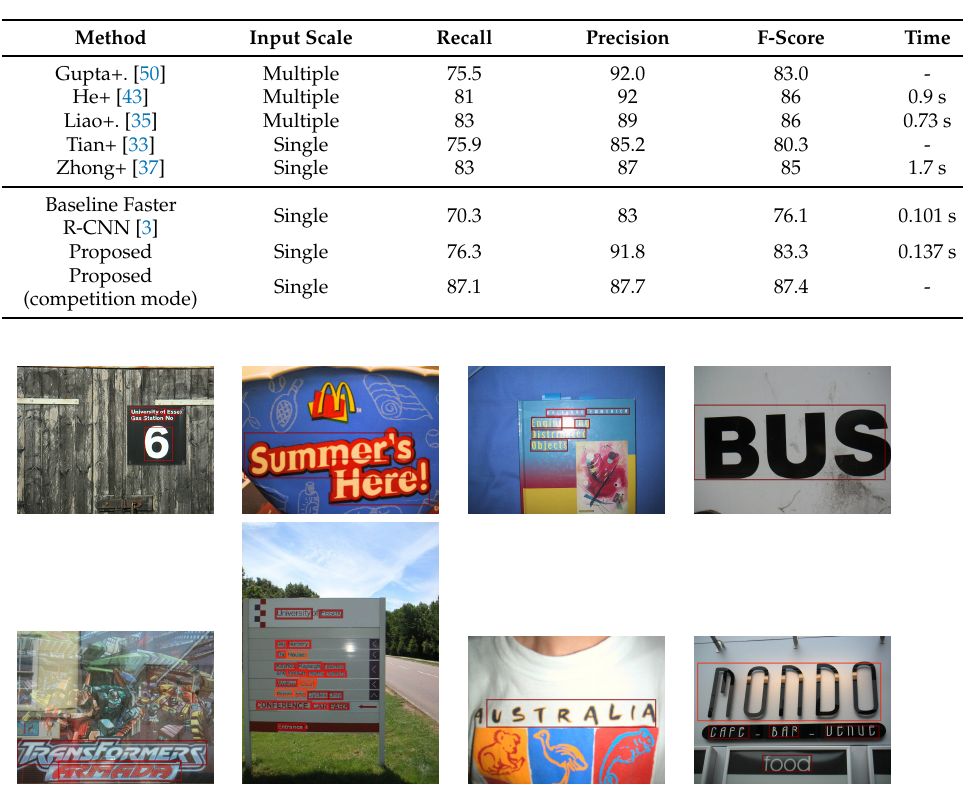
Figure 5. Result examples on ICDAR2013. Red rectangles are detection results by proposed